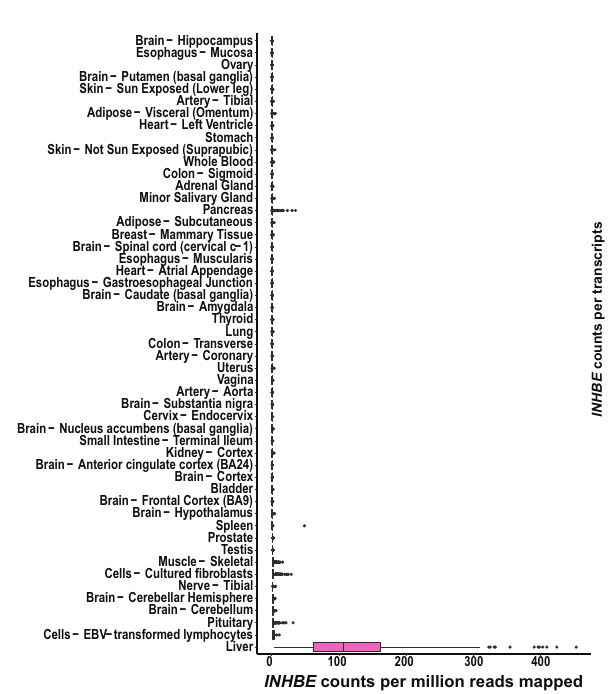
Fig. 4 | INHBE mRNA expression in humans across tissues and liver cell-types. The left panel shows normalized mRNAexpression for INHBE incounts per million (CPM) across tissues from the Genotype Tissue Expression (GTEx) consortium 107 , box plots depict the median, interquartile range, and range of CPM values across